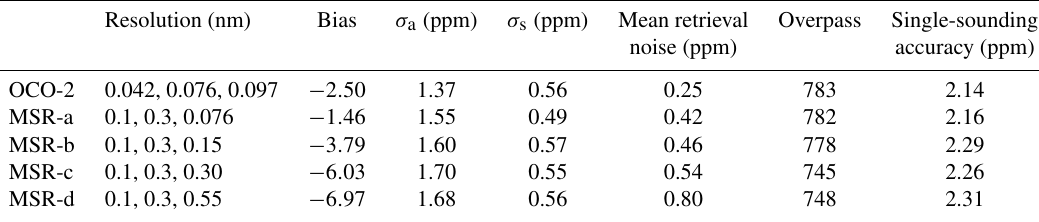
Table 5. XCO 2 retrieval performance for OCO-2, MSR-a, MSR-b, MSR-c, and MSR-d measurements under similar throughput. Here, MSR measurements are generated using OCO-2 measurements.